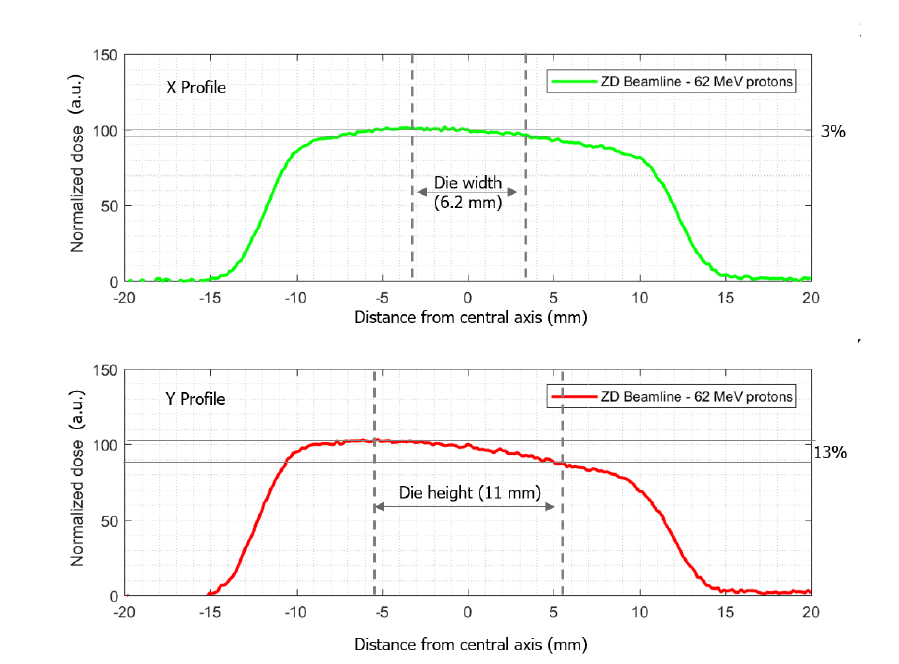
Figure 7. Experimental transverse dose distribution normalized to beam center for 62 MeV protons along x ( top ) and y ( bottom ) axes. The dashed lines indicate the DUT die